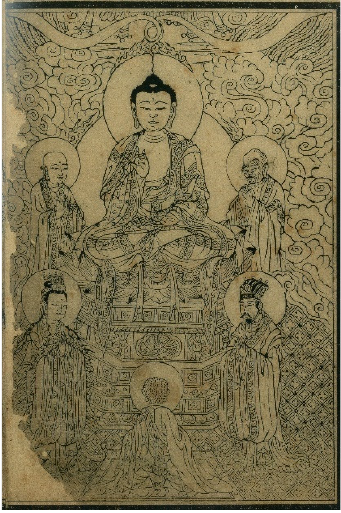
Figure 10. Vimalakirti-Nirdesa Sutra, Ming dynasty, National Palace Museum of Taiwan (National Palace Museum of Taiwan 2015, p. 25).